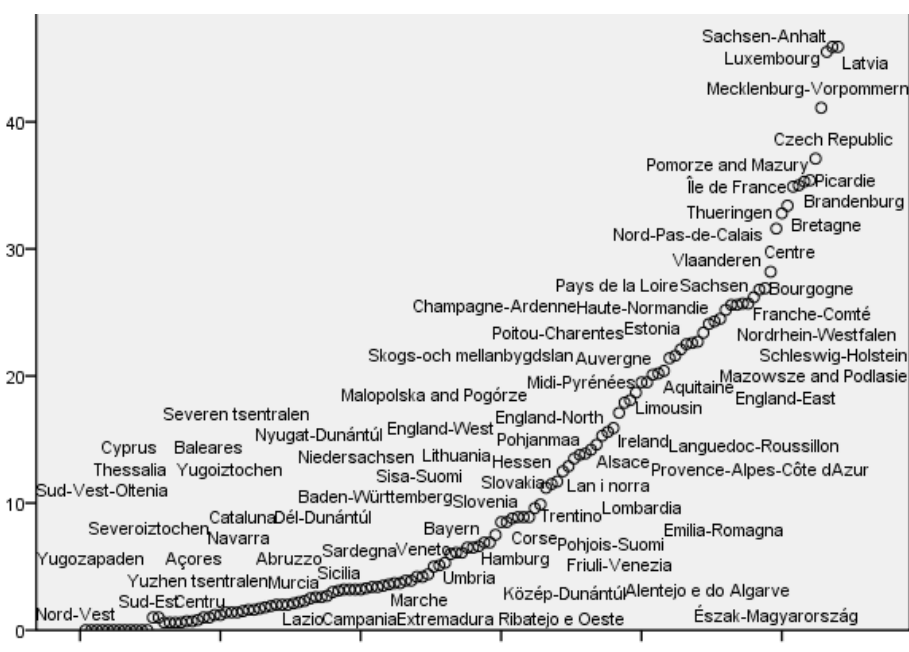
Figure 1. Farm holders with full agricultural training (%),